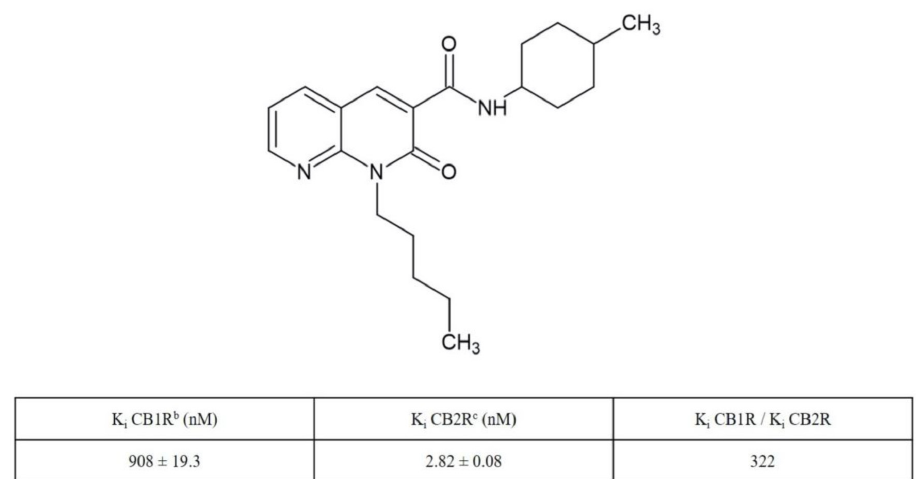
Figure 1. Radioligand Binding Data of 1,8-Naphthyridin-2(1H)-one-3-carboxamide Derivative JT11 a . a Data represent mean values for at least three separate experiments performed in duplicate and are expressed as Ki (nM) for CB1R and CB2R binding assays. b Affinity of compounds for CBR1 was evaluated using membranes from HEK-293 cells transfected with CB1R and [3H]CP-55,940. c Affinity of compounds for CB2R was evaluated using membranes from HEK-293 cells transfected with CB1R and [3H]CP-55,940 [26].